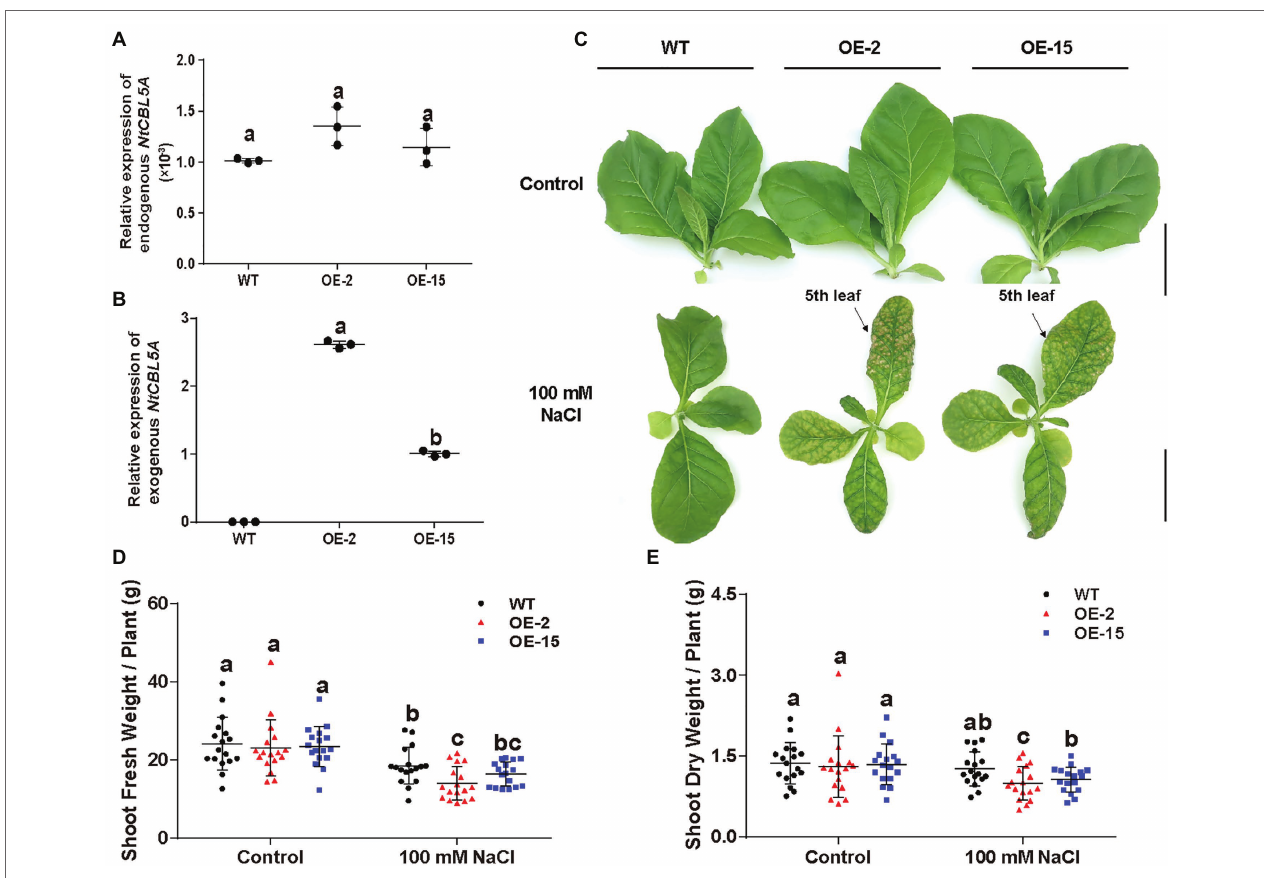
FIGURE 3 | The detection of NtCBL5A expression and above-ground phenotype of wild-type (WT) and NtCBL5A -overexpressing (OE) lines (OE-2 and OE-15) under control conditions and salt stress (100 mM NaCl). Scale bars = 10 cm. (A) Relative expression analysis of endogenous NtCBL5A (the NtCBL5A driven by 35S promoter) determined by RT-qPCR in different tissues of tobacco seedlings at 4 days after the start of treatment (DAT). The expression of NtCBL5A is relative to the reference gene L25 and the seedlings are 30-DAG old. (B,C) Relative expression analysis of endogenous NtCBL5A and exogenous NtCBL5A (the NtCBL5A driven by its own promoter in tobacco) determined by RT-qPCR in whole plants. The expression of NtCBL5A is relative to the reference gene L25 and the seedlings are 12- DAG old. The reverse primer pCHF3-Allcheck-1 used for amplifying exogenous NtCBL5A was designed according to the sequence of the overexpression vector pCHF3, referring to pCHF3-Allcheck-2 (Shi et al., 2021). (D) The shoot phenotype of WT and NtCBL5A -OE lines at 9 DAT. (E,F) The shoot fresh weight and dry weight of WT and NtCBL5A -OE lines at 9 DAT. Error bars indicate ±SD ( n = 3 for gene expression detection, n = 17 for shoot fresh/dry weight determination), different letters above bars (a, b, and c) indicate significant statistical difference based on one-way ANOVA with LSD test ( p <